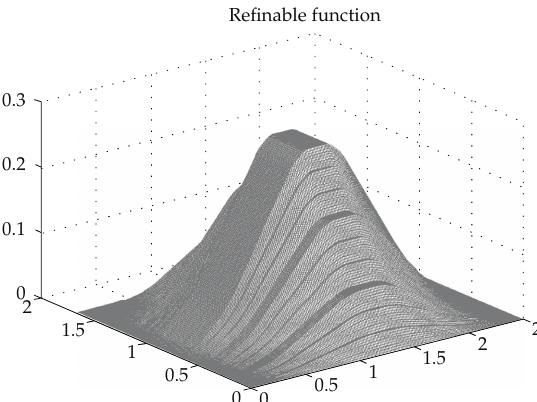
Figure 1: The symmetric refinable componentwise polynomial function f .